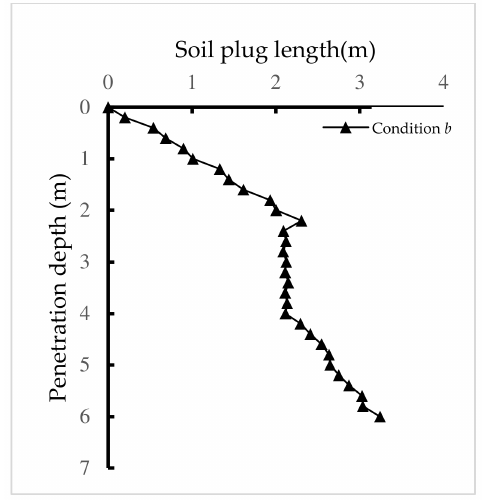
Figure 10. Soil plug length curve for condition b